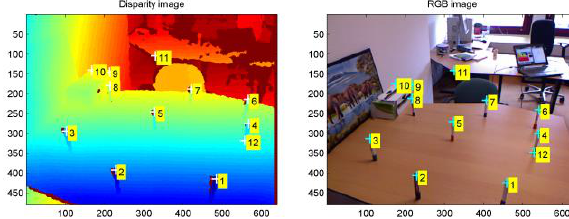
Figure 2. Manually measured markers in the disparity (left) and colour image (right).